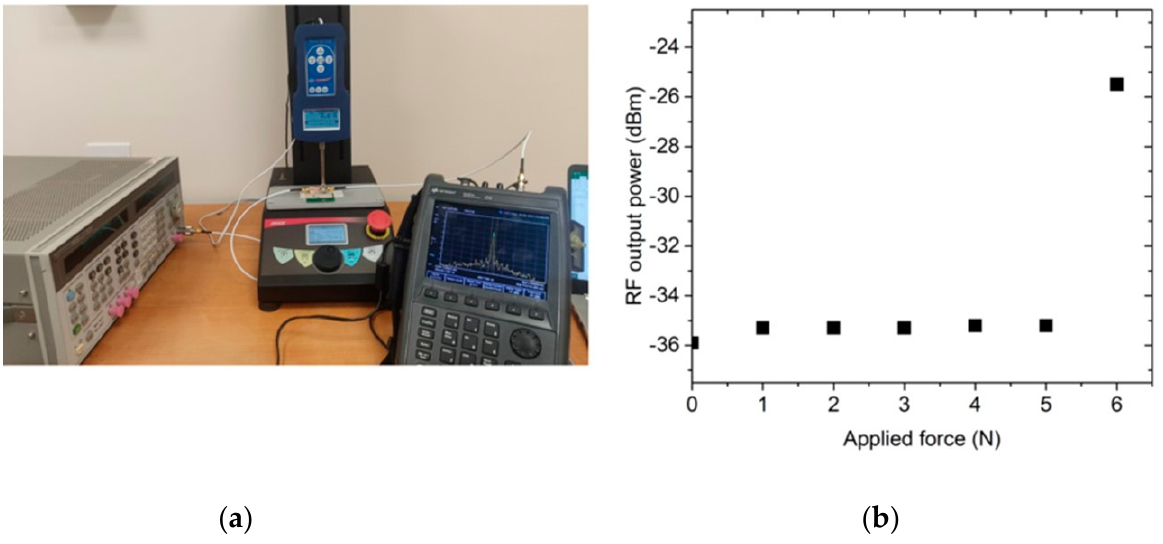
Figure 9. Experimental results for the proposed shock sensor: ( a ) experimental setup and ( b ) obtained results.